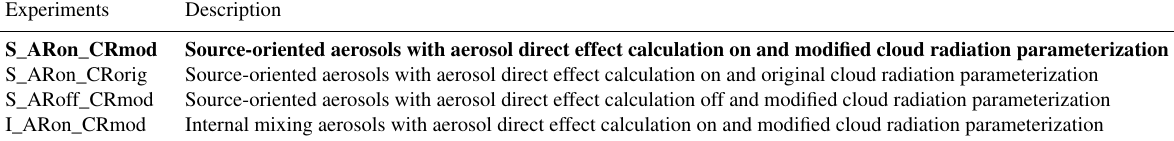
Table 3. Numerical experiment designs for this study. The bold font indicates the base case. Experiments